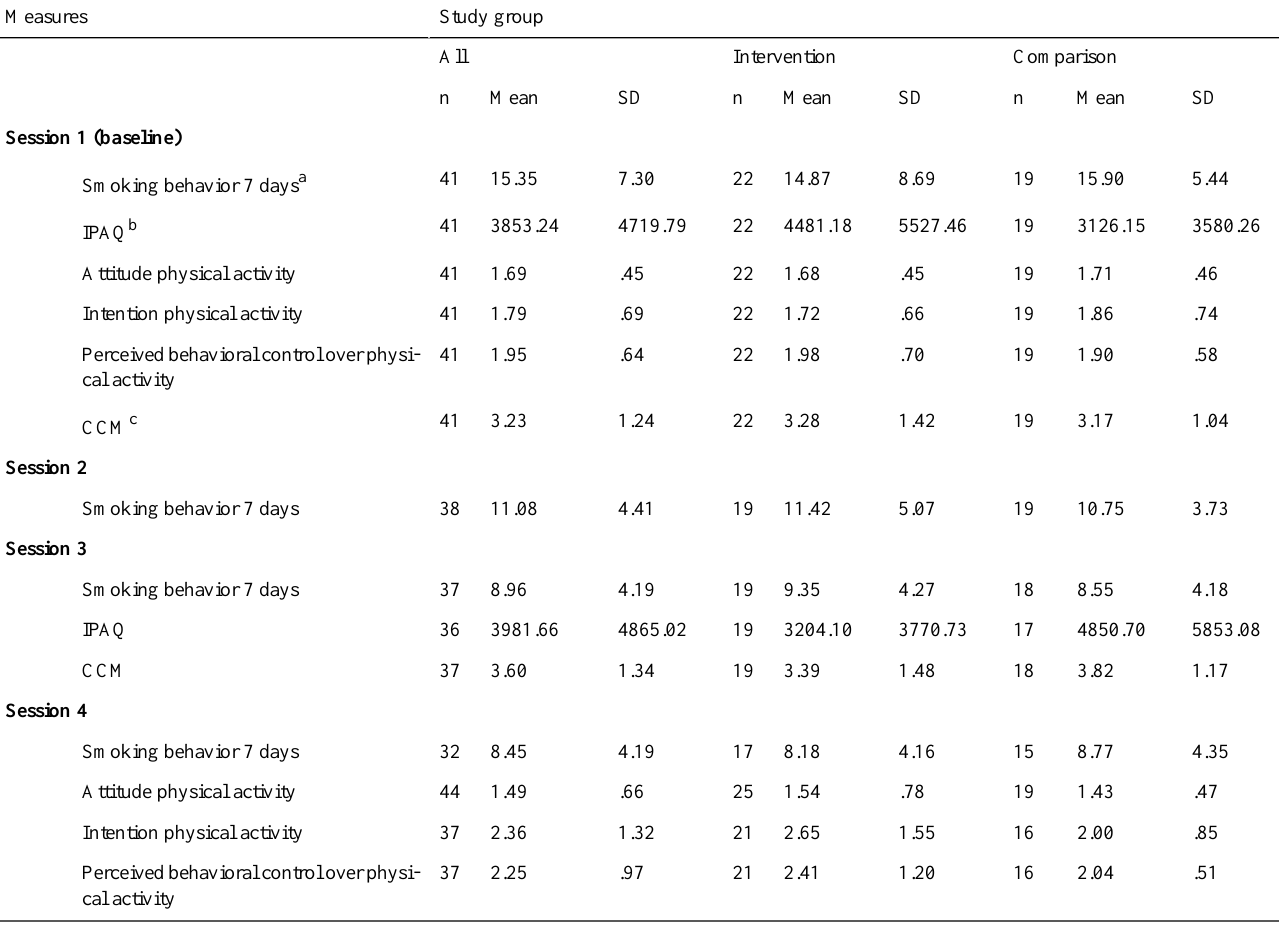
Table 2. Descriptive measures (mean scores) during all sessions by